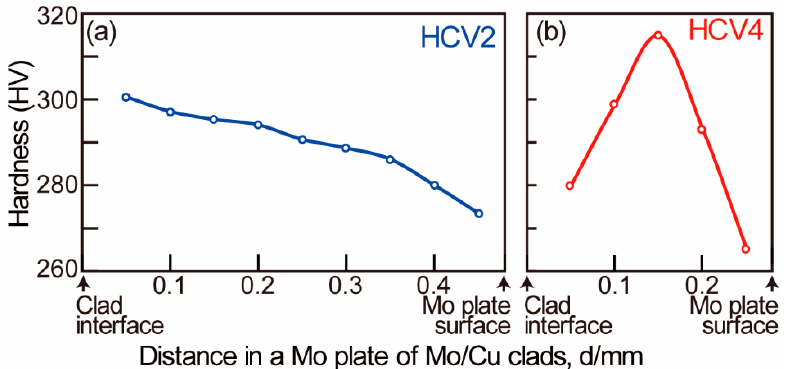
Figure 6. Vickers hardness profiles obtained at room temperature with an applied load of 0.098 N in the cross section of a Mo plate between the interface and Mo plate surface for ( a ) HCV2 and ( b ) HCV4 clads.